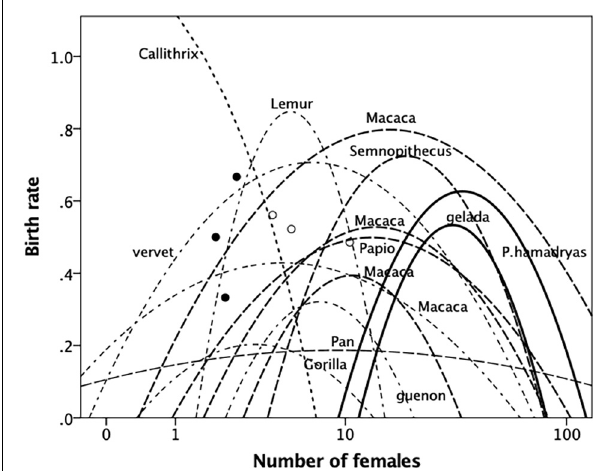
FIGURE 4 | Best-fit quadratic regressions for birth rate (births per female per year) regressed on female group size for different genera of primates. Guenon = Cercopithecus ; vervet = Chlorocebus ; gelada = Theropithecus . Filled symbols: Eulemur ; unfilled symbols: Trachypithecus . Lines in different format indicate clustering of regressions (for further details, see text and Supplementary Material ). Source: Supplementary Dataset 3 .